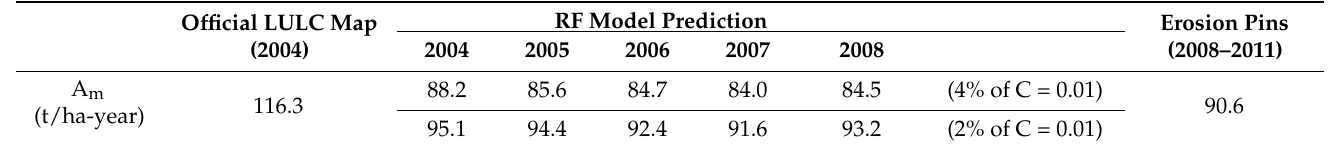
Table 10. The estimation of annual soil loss based on C-factors of different years (4% and 2% sampling